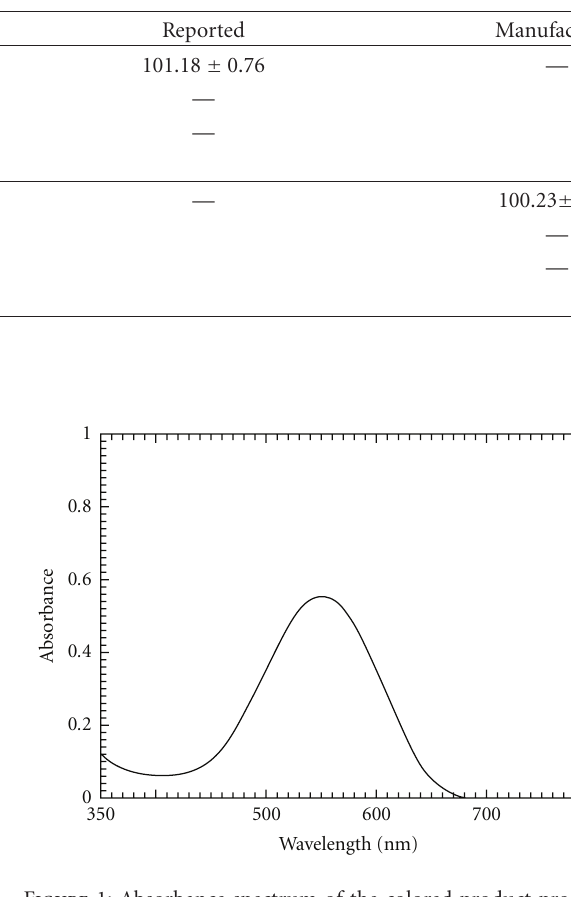
Table 2: Statistical analysis of the results obtained by applying the proposed, reported and manufacturer methods for the analysis of GF and DR in their dosage forms.